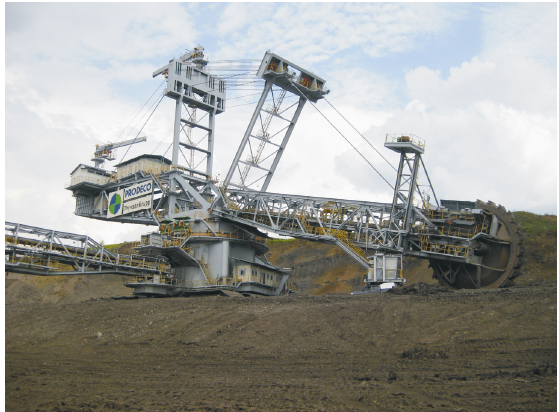
Fig. 1. Overall view of bucket wheel excavator SchRs